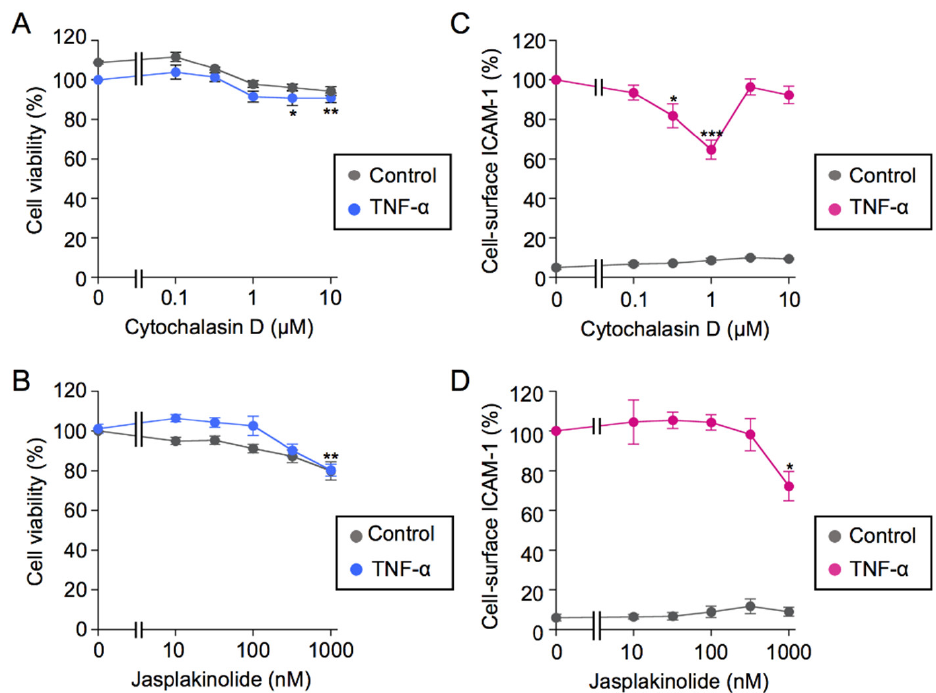
Figure 10. Cytochalasin D and jasplakinolide only partially inhibited TNF- α -induced cell-surface ICAM-1 expression. ( A – D ) A549 cells were pretreated with serial dilutions of cytochalasin D ( A , C ) or jasplakinolide ( B , D ) for 1 h and were then treated with (blue circles in A , B and red circles in C , D ) or without (gray circles) TNF- α (2.5 ng/mL) in the presence of cytochalasin D or jasplakinolide at the indicated final concentrations for 6 h. Cell viability (%) ( A , B ) and cell-surface ICAM-1 (%) ( C , D ) are shown as the mean ± S.E. of three independent experiments. * p < 0.05, ** p < 0.01, and *** p <